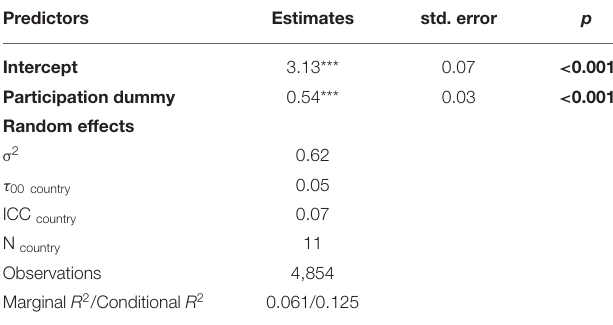
TABLE 5 | Feeling of “Togetherness” as a function of participation in balcony